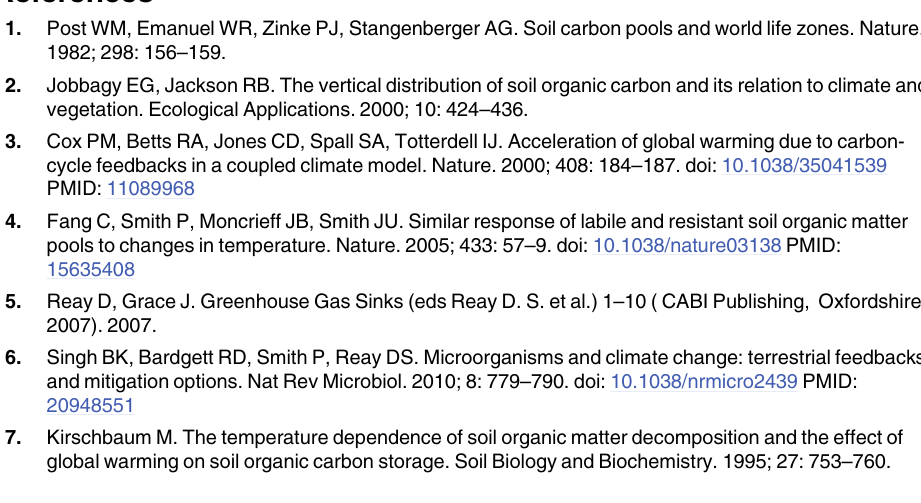
S5 Table. Temperature sensitivity of dehydrogenase activity expressed per chloroform level (95% confidence intervals do not